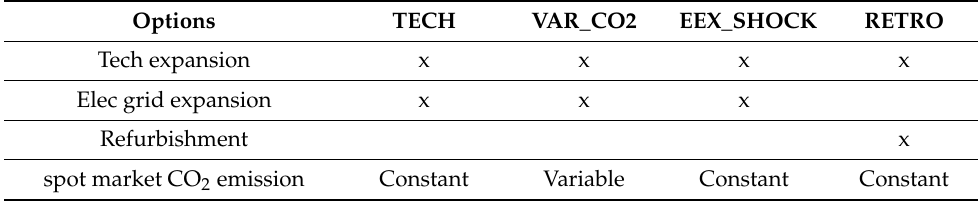
Table 4. Scenario selection and main